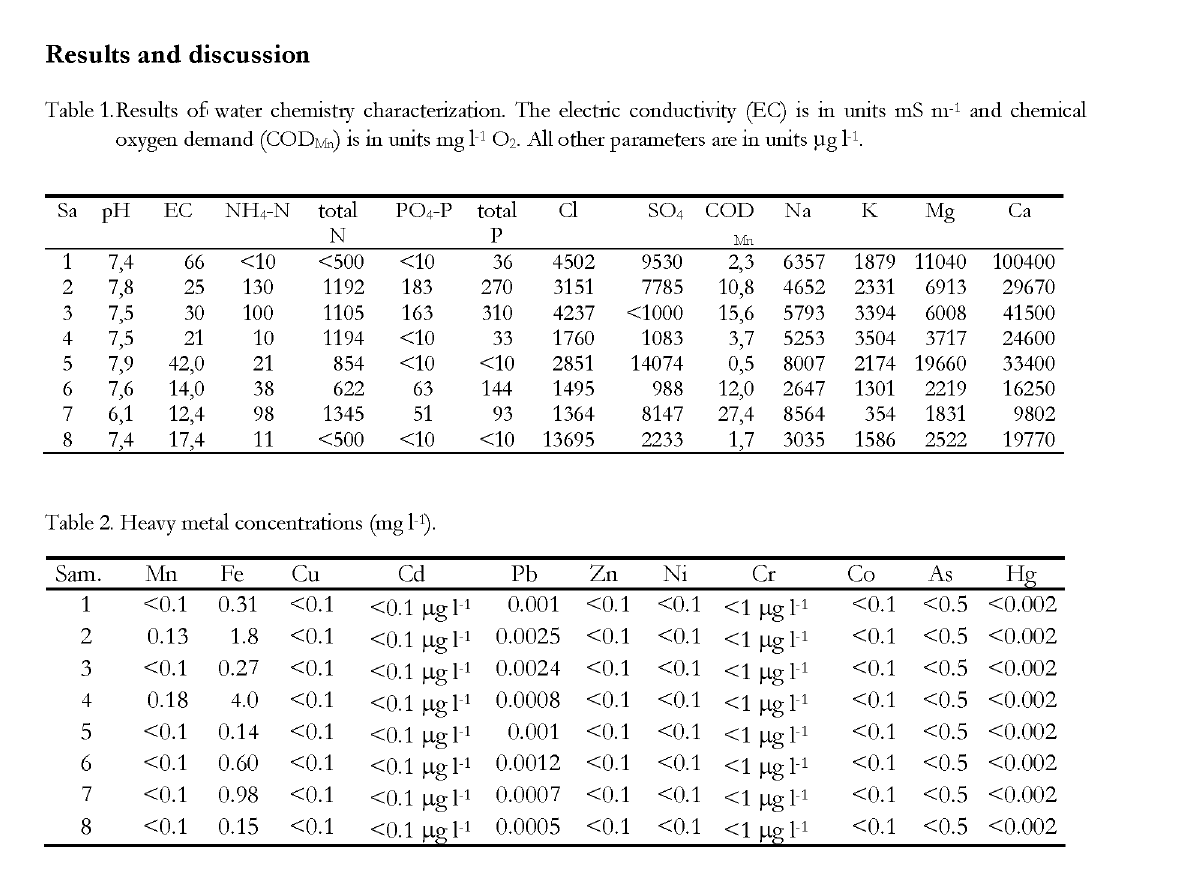
Table 1. Results of water chemistry characterization. The electric conductivity (EC) is in units mS nr 1 and chemical